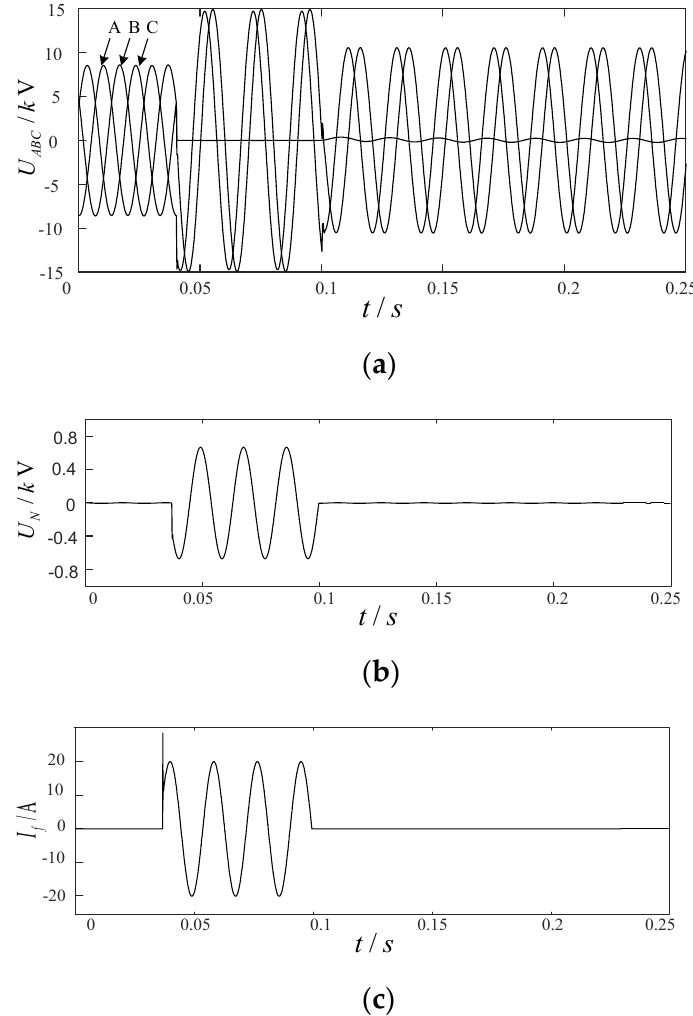
Figure 7. Simulation waveforms: ( a ) three-phase voltage U A , U B , and U C of 10 kV distribution network; ( b ) neutral point voltage U N ; ( c ) fault current I f. Table 2. Comparison of the fault current before and after flexible grounding.